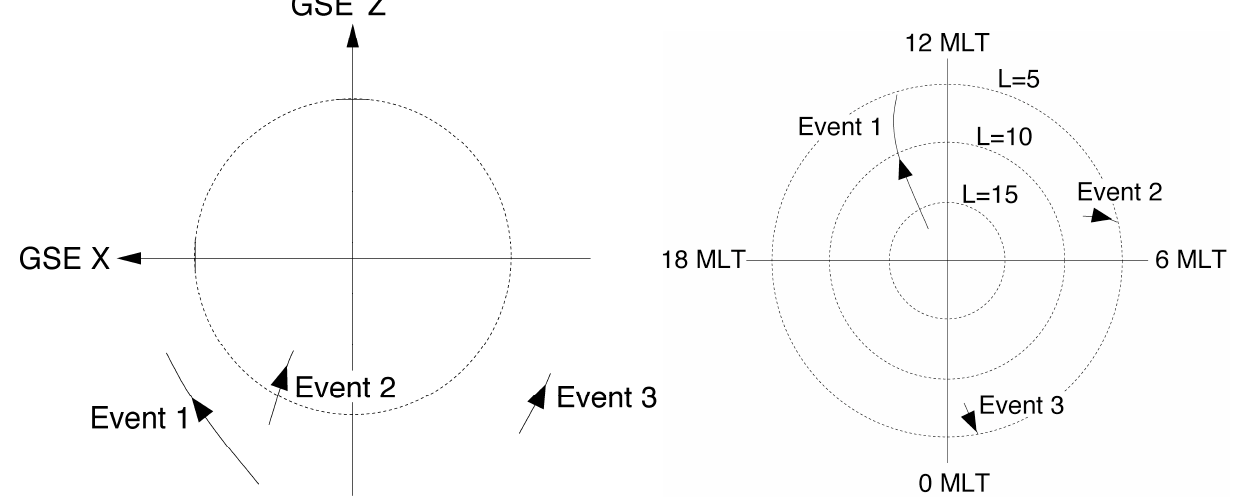
Figure 2: Orbit projections of the three traversals in X-Y GSE and MLT-L shell. Fig. 2. Orbit projection sketches of the three traversals in X-Y GSE and MLT-L shell. For more details, see Table 1. distributions of H + , O + and He + and comparing their den- rent H + and O + by Collin et al. (1993), some of the Right column, line 10: the correct is ”perigee of ∼ 4 R Right column, line 16: the correct is ”ring current”, NOT ”Ring current”.